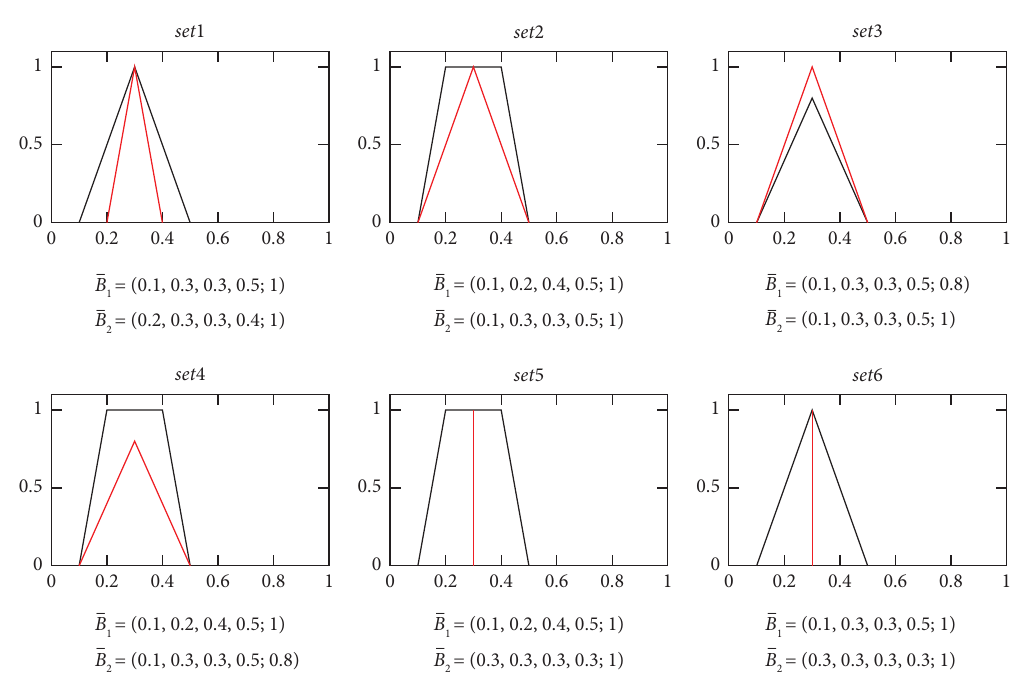
Figure 2: B Z -numbers in the 6 sets. i of